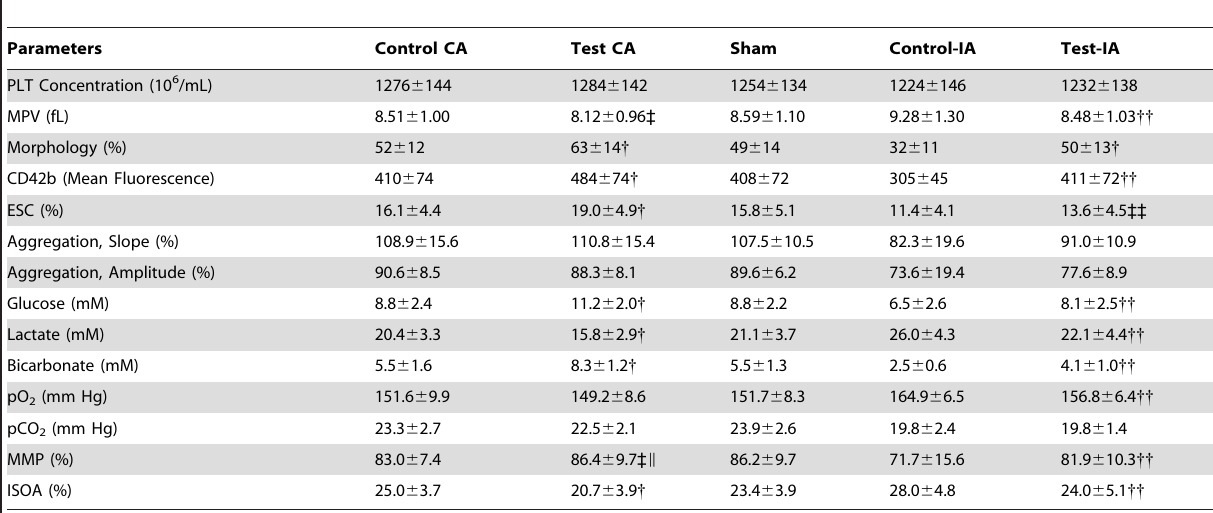
Table 1. PLT parameters assessed on Day 7 of storage with continuous and interrupted agitation with or without a MAPK inhibitor,